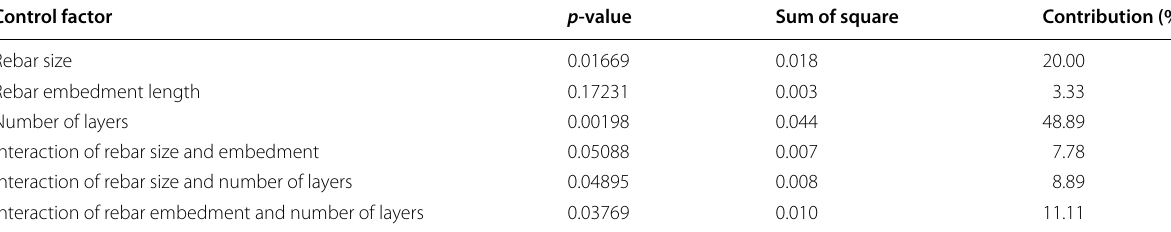
Table 11 ANOVA analysis for ultimate strain.